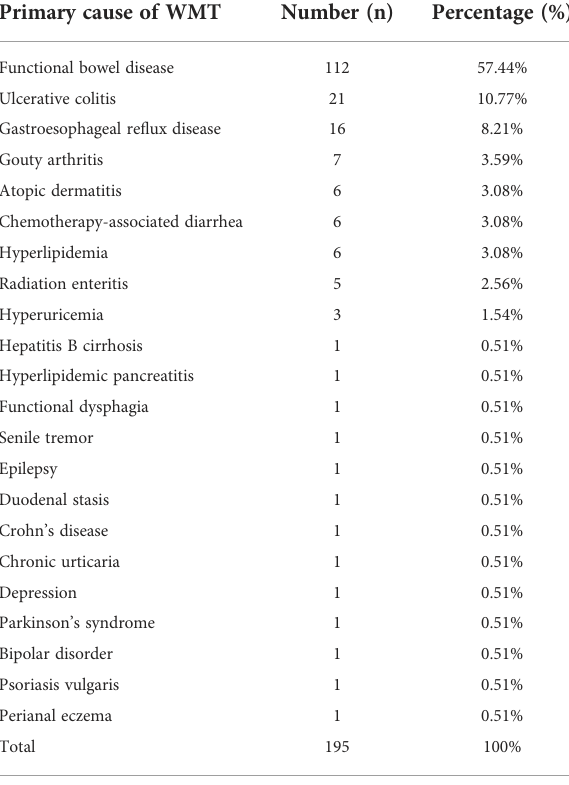
TABLE 1 The main diagnoses of patients receiving washed microbiota transplantation. Primary cause of